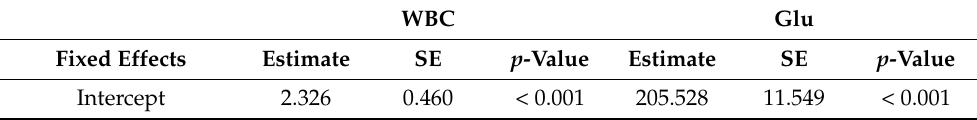
Table 3. Estimated model coefficients for the GLMM model of WBC (white blood cell) count and the LLM model of the Glu (glucose) level in the blood of free-living marsh harrier nestlings. The hatching order of nestlings is labelled chronologically with letters ( b , c , and d ); brood size is indicated by numbers ( 2, 3 , and 4 ). Standard errors (SE) and p -values are shown for the fixed effects. The values of the random effects are variance estimates and their standard deviations